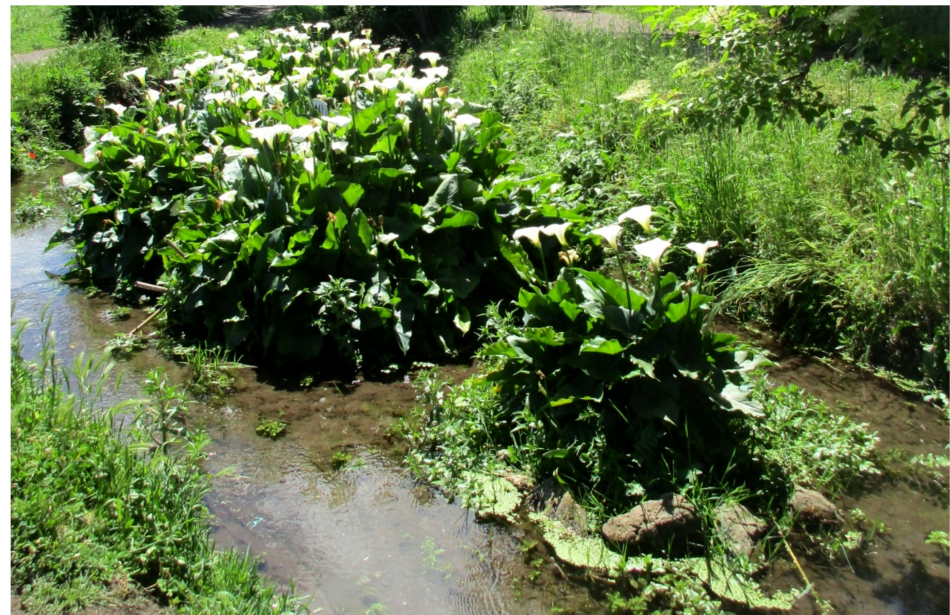
Figure 63. Zantedeschia aetiopica along channel Acqua Mariana (Acquedotti